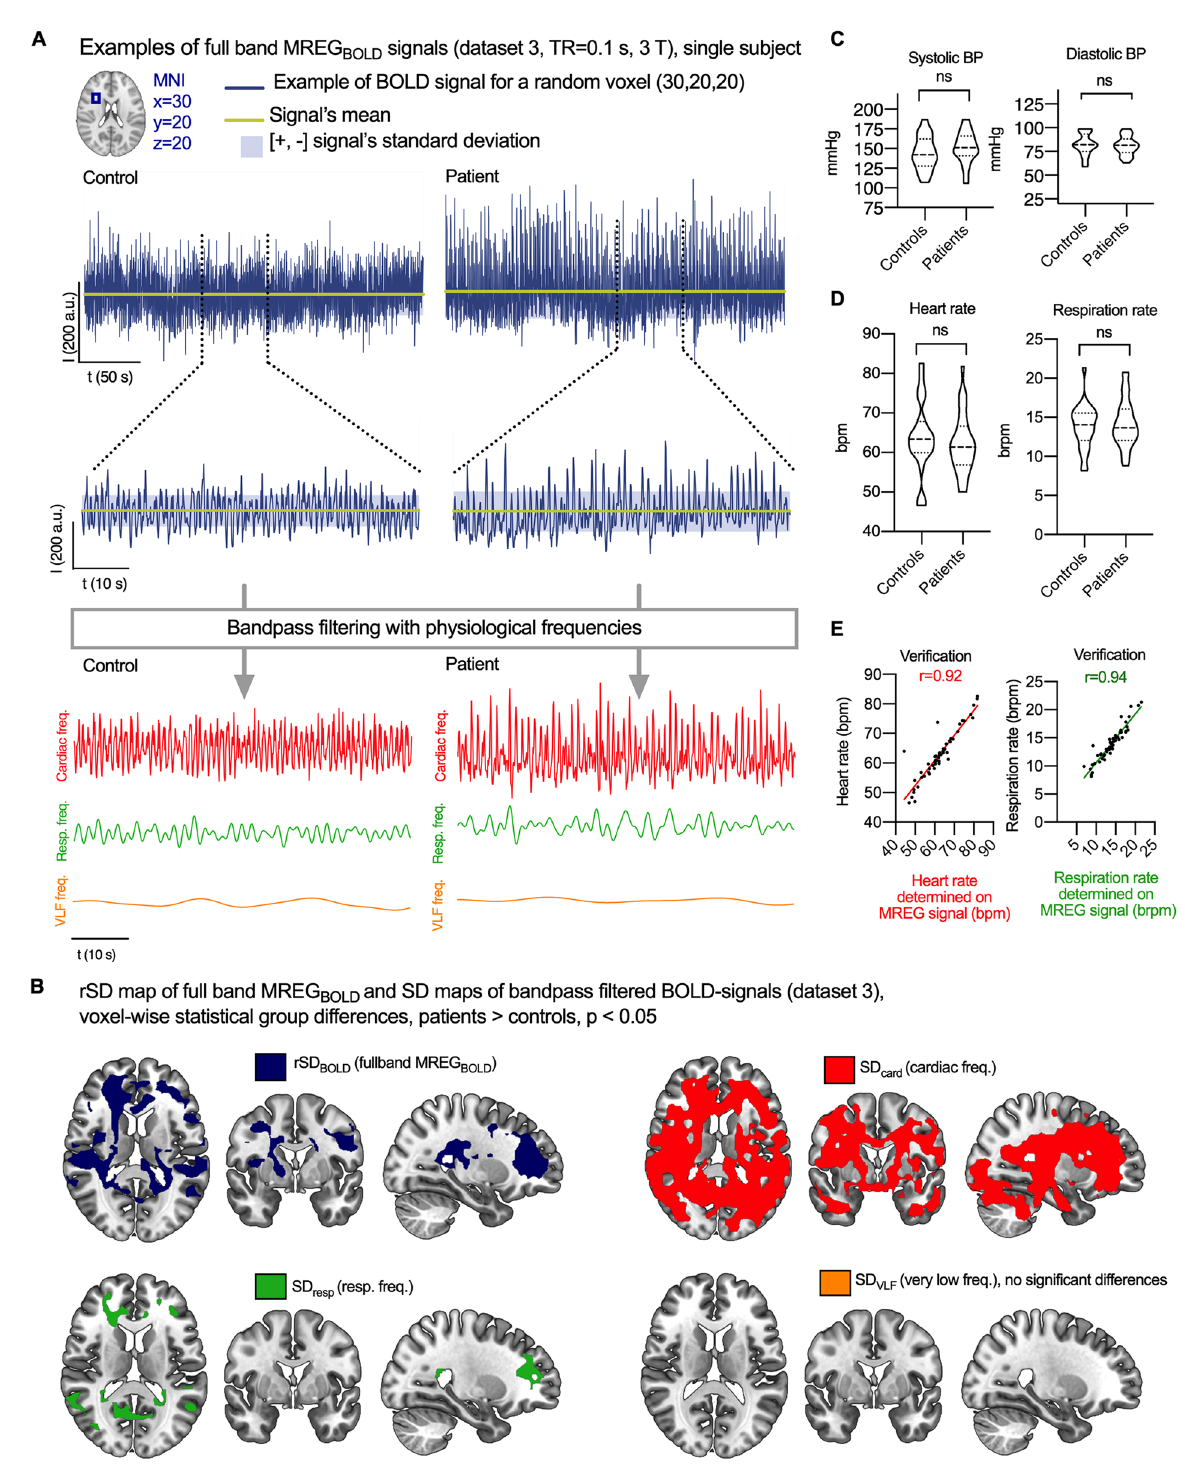
Figure 4. Physiological source mapping. ( A ) MREG BOLD signal is imaged with fast sampling rate (TR = 0.1 s). A representative 60 s clip is shown for the purposes of illustration. MREG BOLD signal is bandpass filtered to physiological frequencies to study the cardiac, respiratory and VLF parts of the signal. ( B ) Differences in rSD BOLD and SD of bandpass filtered signals according to whole-brain voxel-wise analyses. Maps represent group-level differences where SD is higher in Alzheimer’s disease patients (P < 0.05, family wise error corrected). ( C ) Blood pressure (BP) while supine just prior to entering the MR scanner. ( D ) Heart and respiration rates from peripheral pulse oximeter and respiration belt, respectively. ( E ) Heart and respiration rates determined on MREG signal and their correlation to peripheral signals. NS = not